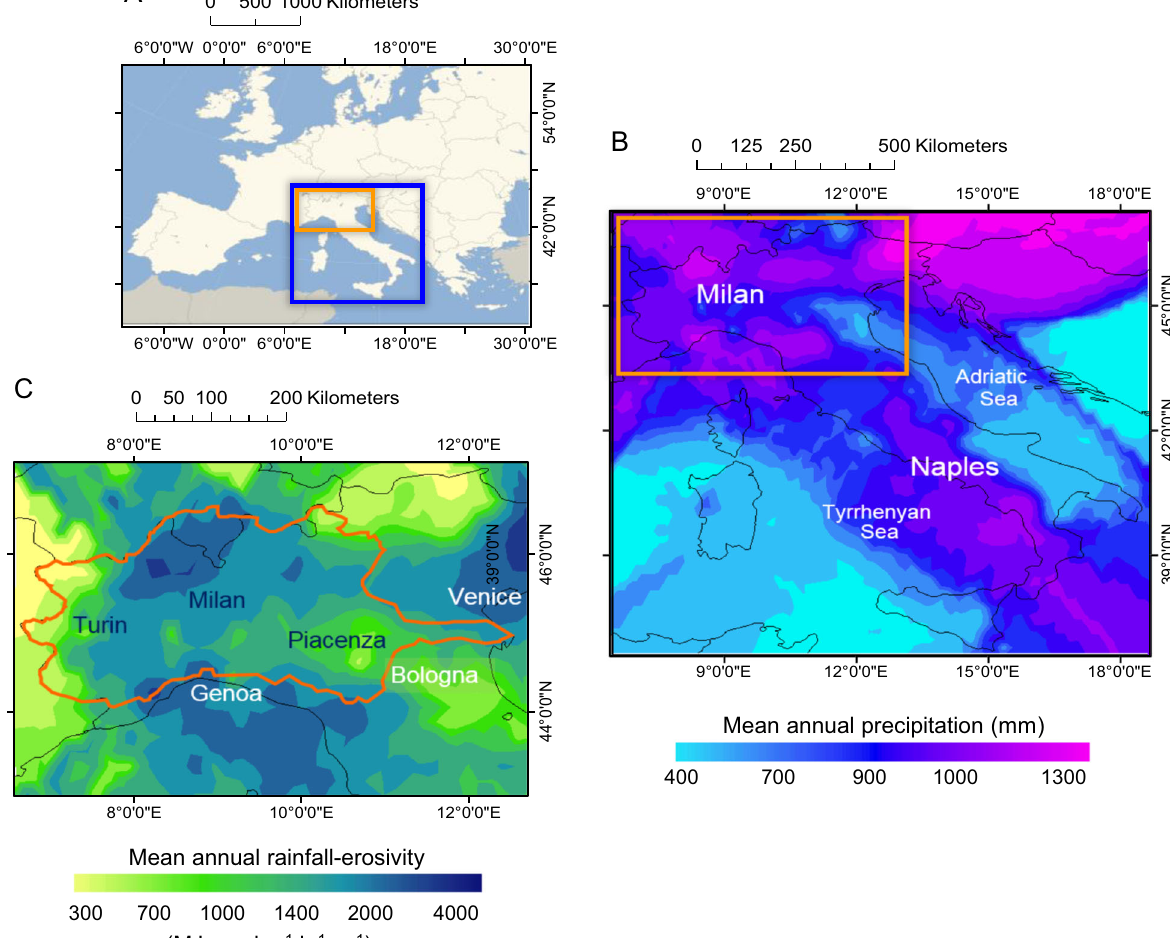
Fig. 2 Environmental setting and rainfall erosivity across northern Italy. Study region in the European context ( A ) spatial pattern of mean annual precipitation over the central Mediterranean area ( B ), and mean annual rainfall erosivity across Po River landscape (orange curve) over the period 1994 – 2013 ( C ) (arranged with Geostatistical Analytics by ArcGIS-ESRI on the ESDAC-dataset, https://esdac.jrc.ec.europa.eu/content/ global-rainfall-erosivity) 123